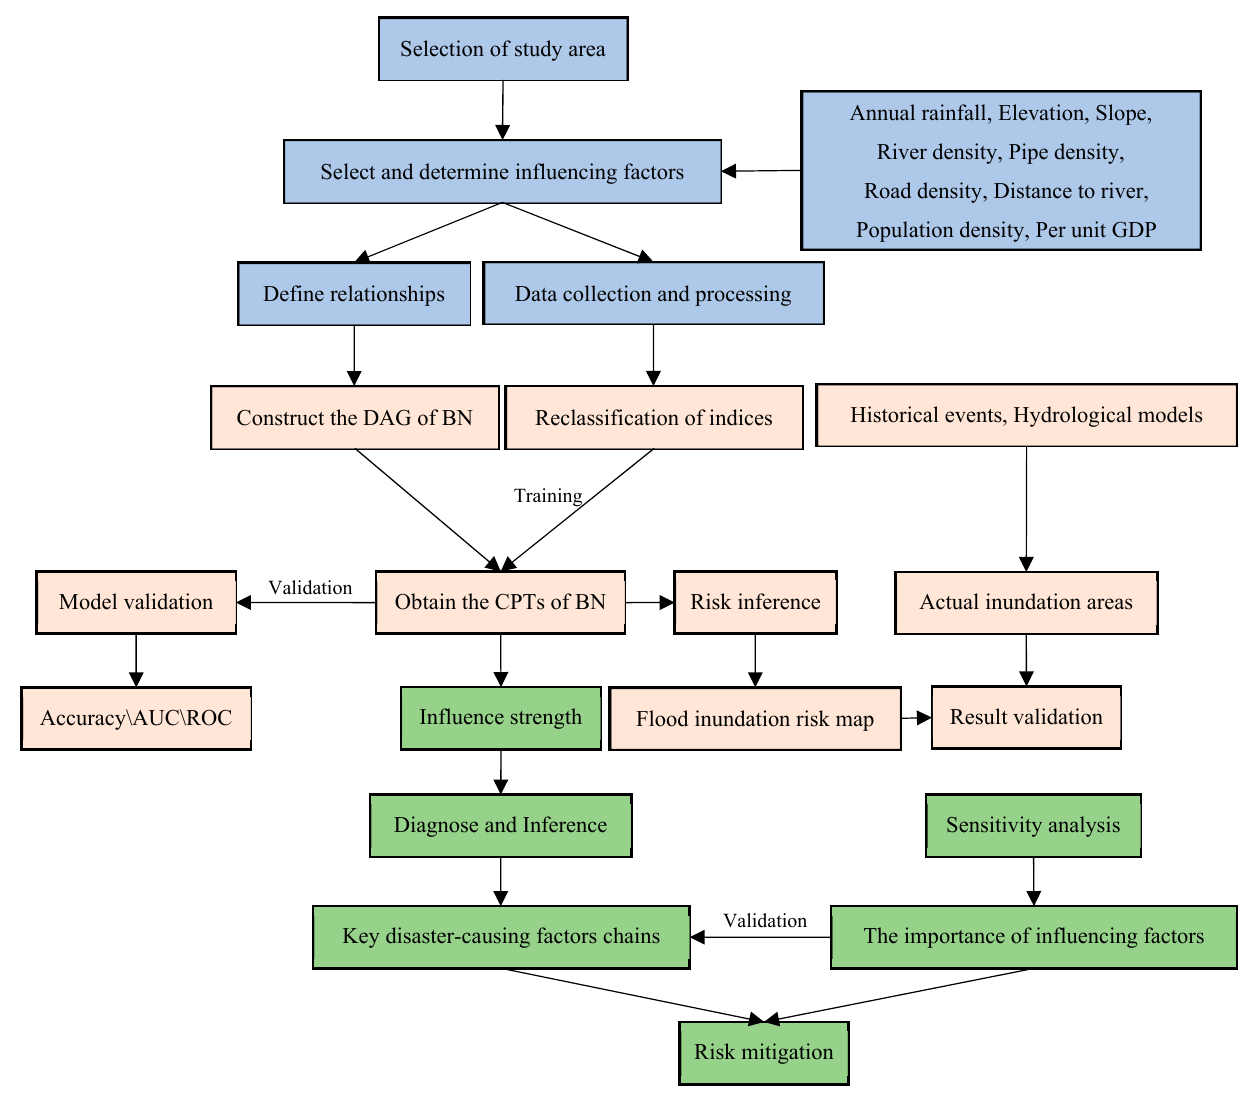
Figure 1. Framework of the proposed method.